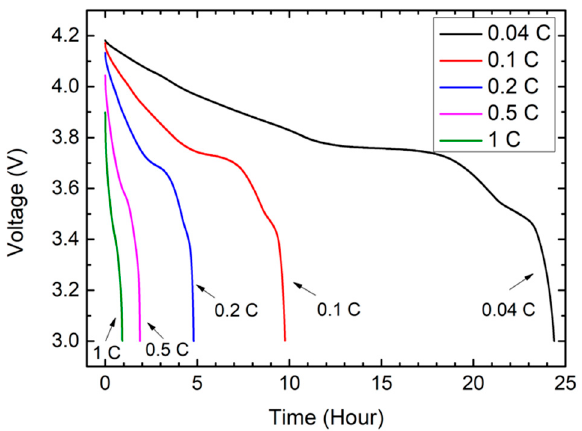
Figure 3. Discharge curve of L brand 18650.